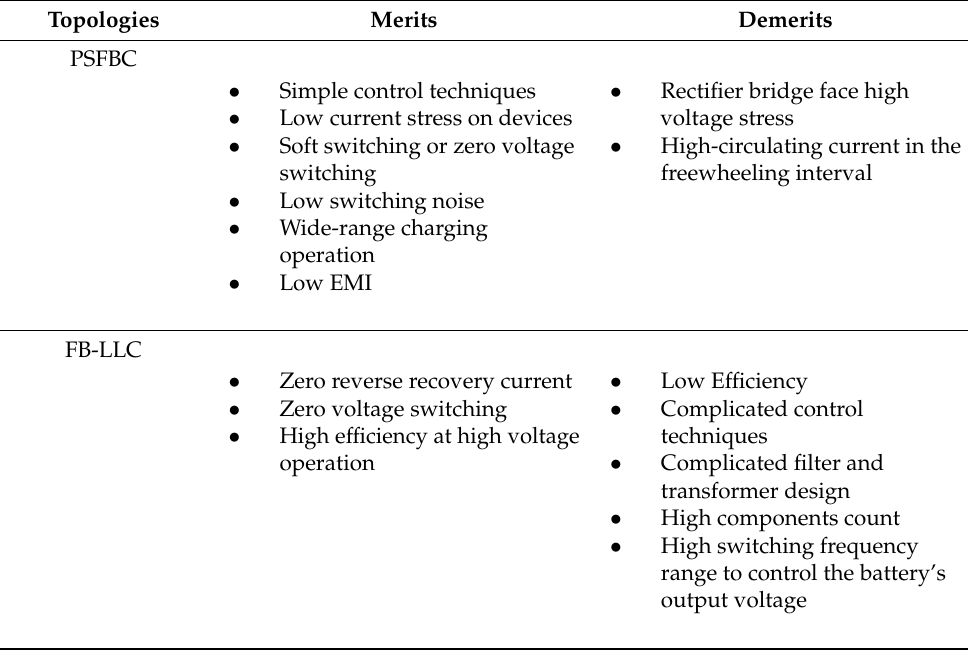
Table 7. Summary of onboard